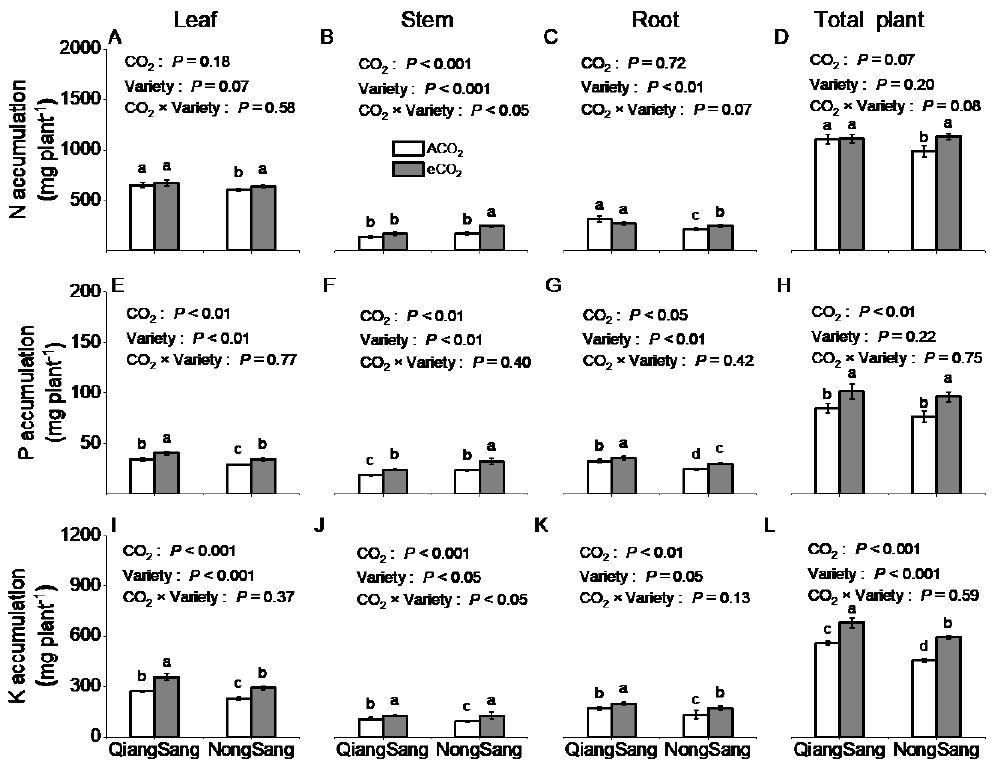
Figure 4. Accumulation of nitrogen (N: A – D ), phosphorus (P: E – H ) and potassium (K: I – L ) in leaves, stems, roots and total plants of two mulberry varieties ( Morus multicaulis Perr. var. QiangSang and NongSang) grown under ambient CO 2 (ACO 2 , 410/460 ppm, daytime/nighttime) and elevated CO 2 (eCO 2 , 710/760 ppm) levels. Data (means ± SE, n = 3) followed by different letters indicate significant differences ( p < 0.05) as revealed by Tukey’s test. Statistical comparisons (two-way ANOVA) between varieties and CO 2 treatments as well as their interaction (CO 2 × variety) are presented for each variable.